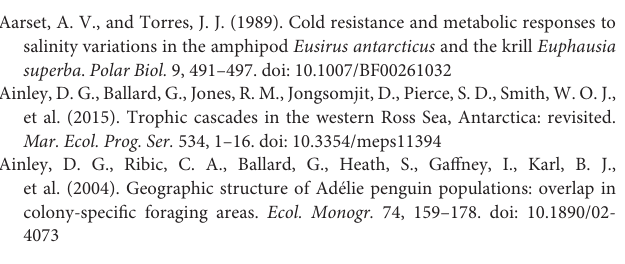
figure production. MHP provided analyses of SO-CPR data. All (E) pteropod abundance from the combined Boosted Regression Tree model of